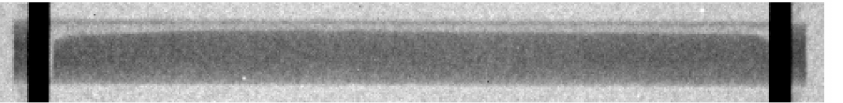
Figure 10. “Virgin” SINQ target rod (outer diameter approx. 10 mm) as imaged with thermal neutrons before implementation in the target